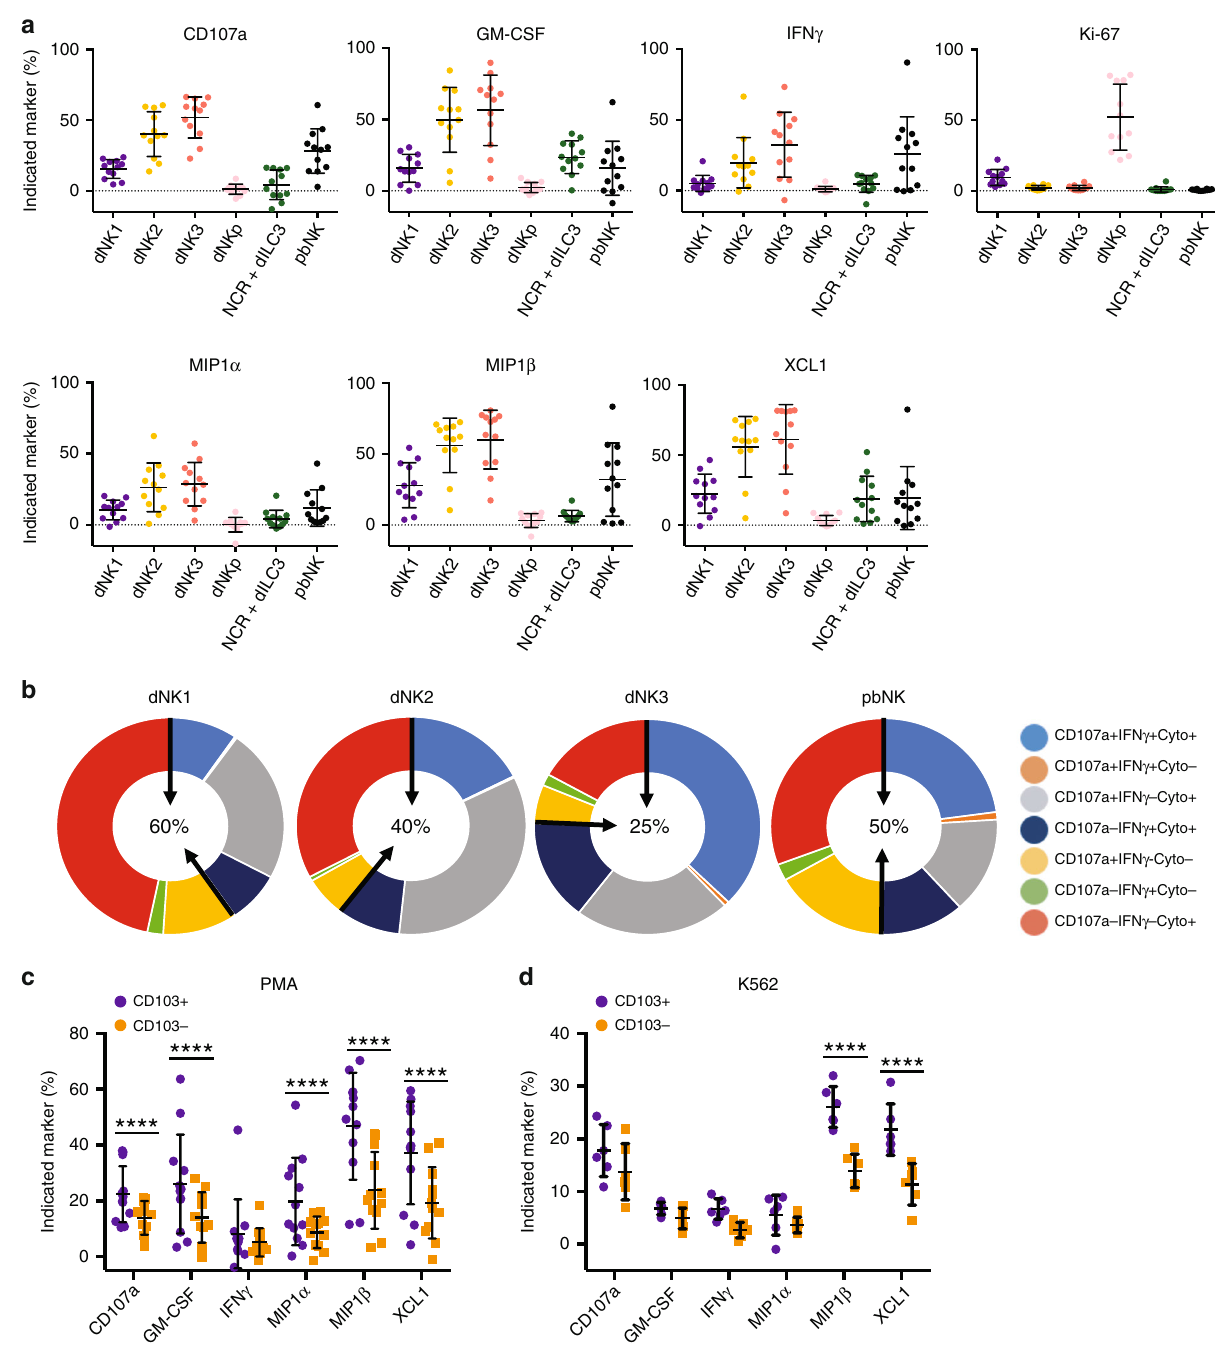
Fig. 3 dILC responses to unspeci fi c stimulation or missing self. a Decidual mononuclear cells were stimulated for 4 h by PMA plus ionomycin in the presence of protein transport inhibitors. A new tSNE landscape was generated using the markers indicated in the fi nal column of Supplementary Table 1. Lineage negative (Lin − ) CD56 + subsets identi fi ed in Fig. 2 were manually gated on the tSNE plot to show dNK1 (c10 – c13), dNK2 (c9), dNK3 (c5, c8), dILC3 (c6), dNKp (c7) and pbNK (c1, c2). Scatter plots show proportion of cells within each subset staining for functional readouts or Ki-67 ( n = 12). Values represent stimulation minus unstimulated media control for each subset. Error bars represent SD. b Pie charts show the mean percentage of each subset that express one, two or three functional readouts as a measure of polyfunctionality, following stimulation. Readouts were: CD107a and/or IFN γ and/or at least one of the cytokines MIP1 α , MIP1 β , GM-CSF, XCL1 (Cyto). Non-responding cells that expressed none of the functional readouts were excluded. Figure in centre shows percentage of responding cells that express only one of the readouts (red, green and yellow segments, delineated by black arrows) (dNK1 – 3 n = 12, pbNK n = 7). c dNK1 are strati fi ed by CD103 expression in response to PMA plus ionomycin ( n = 12) and d 6 h co-culture with K562 ( n = 6). Error bars represent SD. a Two-tailed one-way ANOVA of matched data points with Tukey ’ s correction was performed. c , d A RM two-way ANOVA of matched data points was performed with Sidak ’ s multiple comparisons test. p -values of comparisons for a are found in Supplementary Table 4. Where indicated, **** p < 0.0001. Source data are provided as a Source Data fi